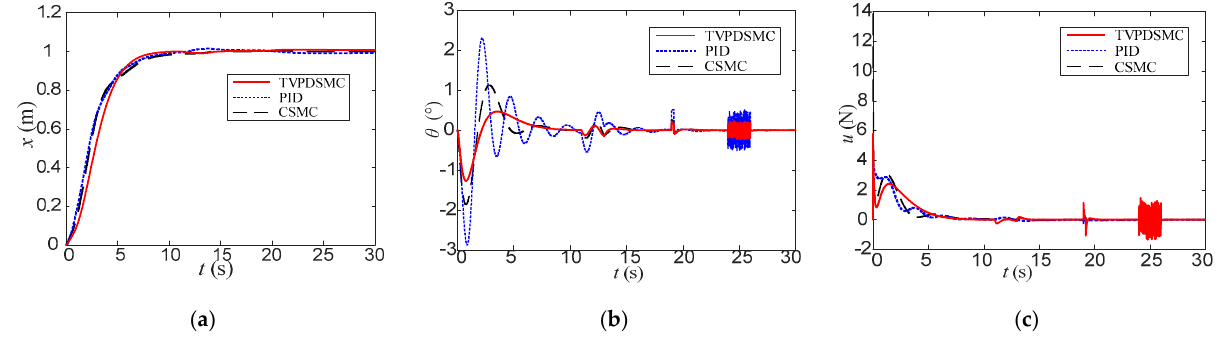
Figure 5. Simulation 3: System state variable response curve. ( a ) Trolley Displacement; ( b ) Payload